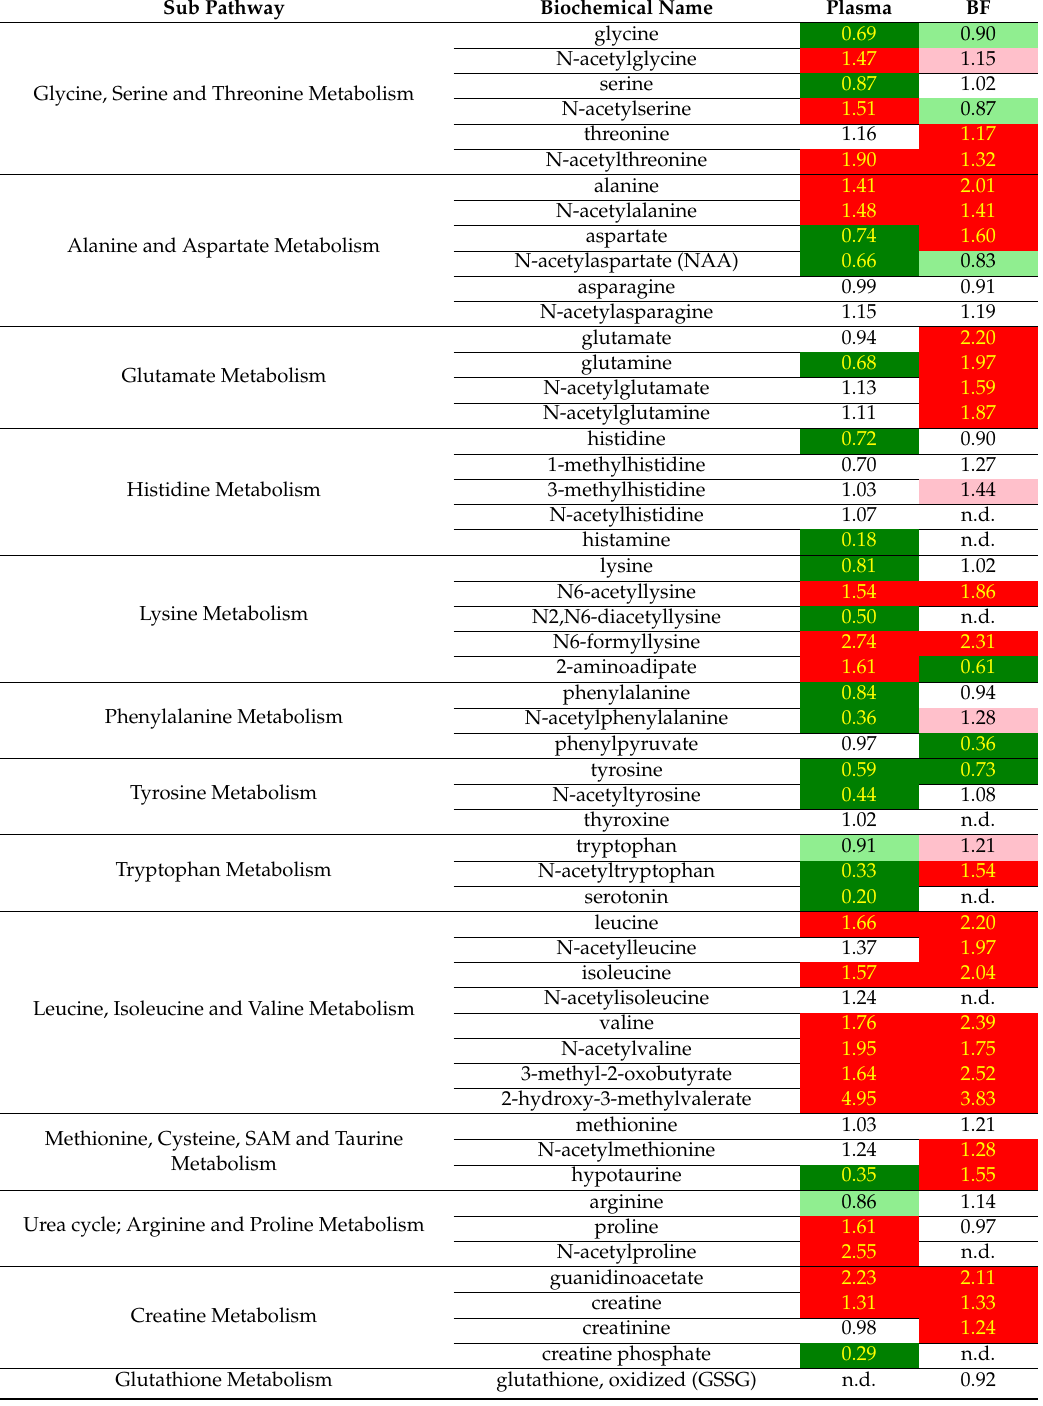
Table 4 footer: Amount was calculated as ratio (fold change) of the diabetic vs. non-diabetic value (Mean MW, n = 8). The statistical significance is indicated in the list by colors with p ≤ 0.05 in dark green and red and those approaching significance (0.05 < p < 0.10) with light green and red. Other important amino acids like glycine, serine, glutamine, histidine and lysine are reduced in the maternal plasma, but not a ff ected, increased or tend to be reduced in BF samples. Phenylalanine and tyrosine, as well as their derivatives, are reduced in both BF and plasma. The levels of